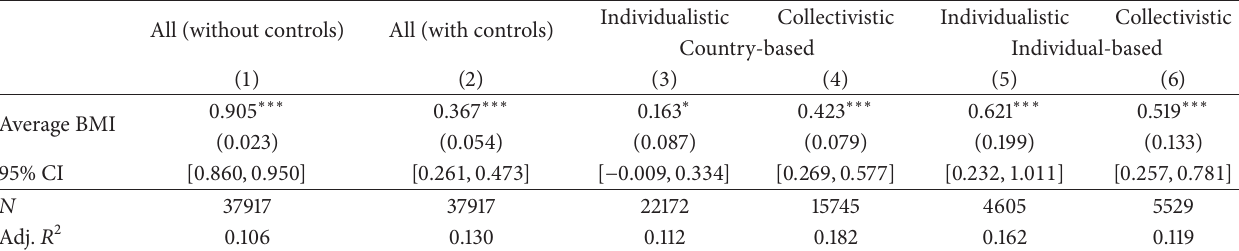
Table 1: OLS estimates of average BMI on individual BMI (individualistic versus collectivistic). All (without